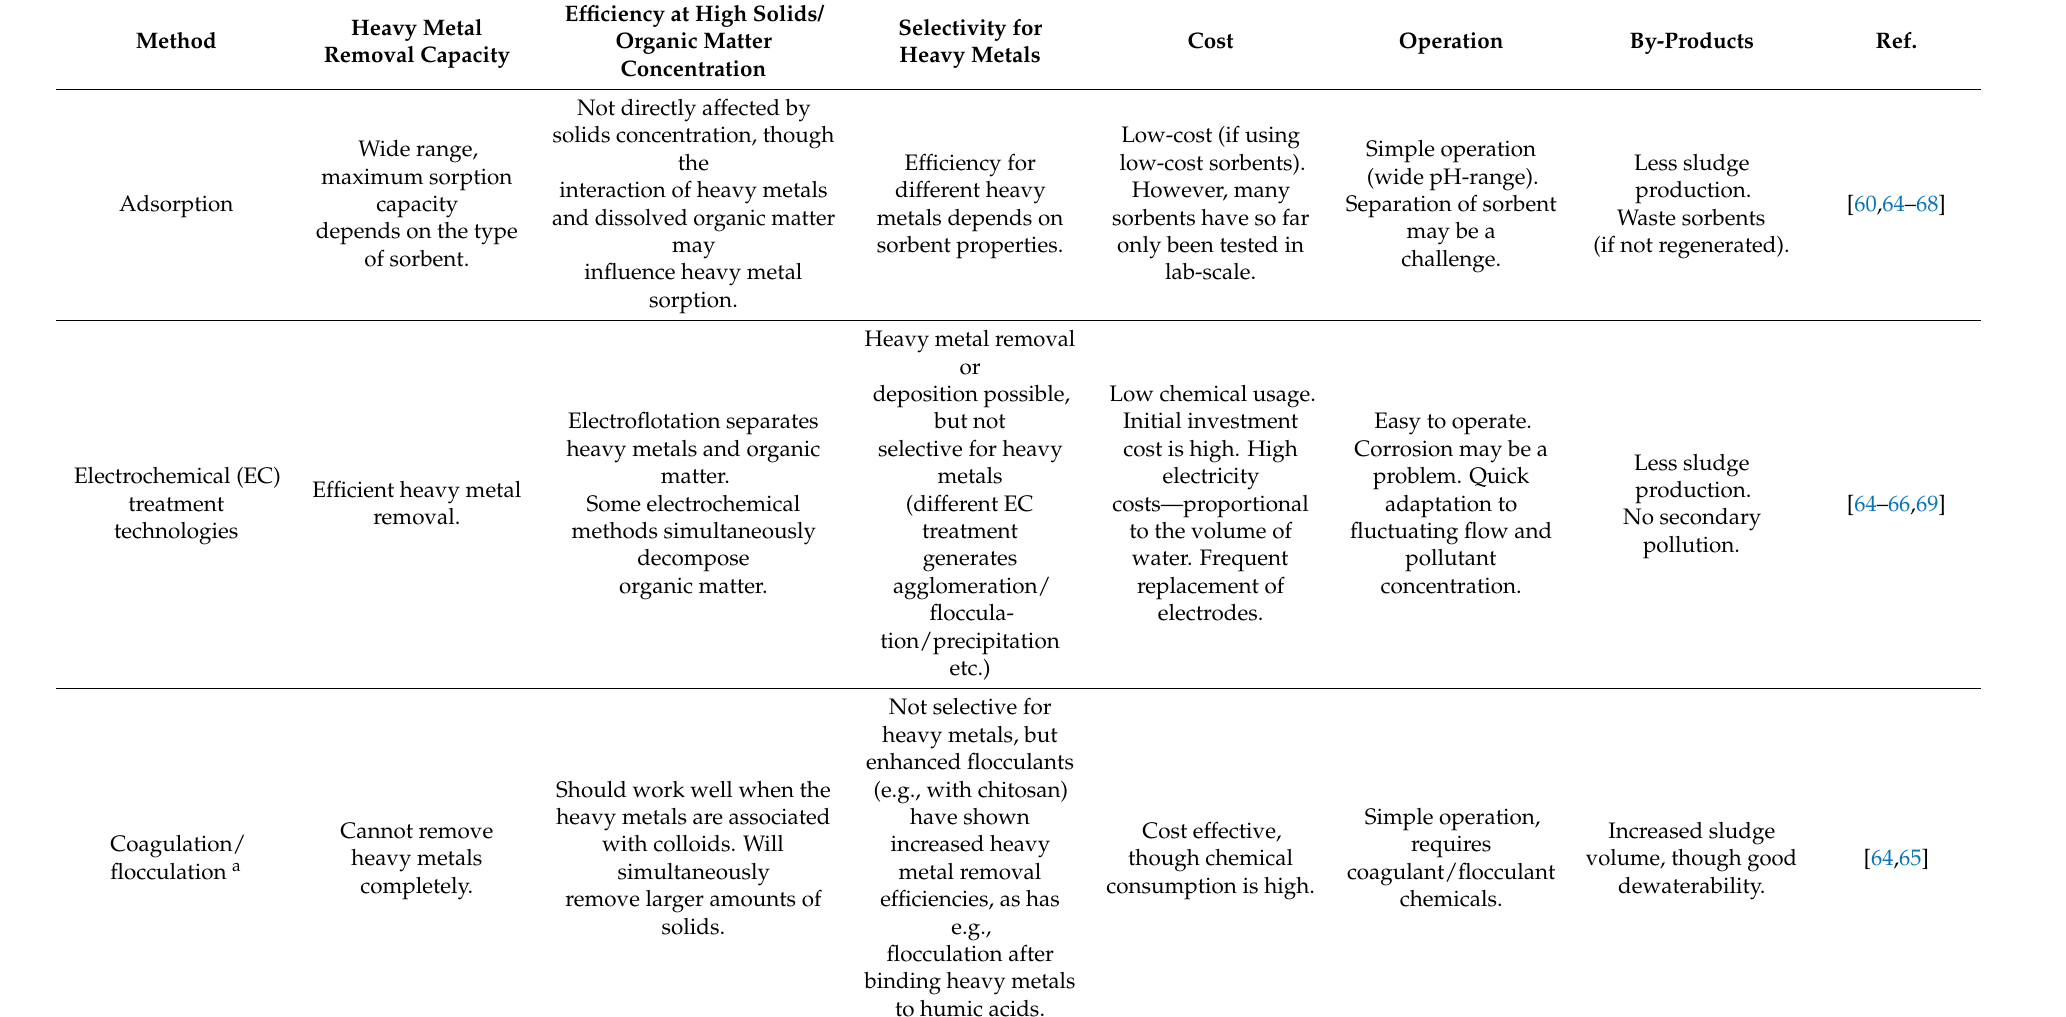
Table 4. Features of heavy metal removal